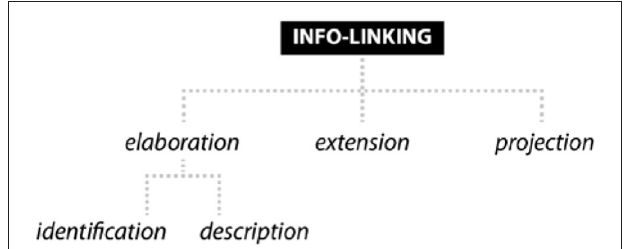
FIGURE 5 | Taxonomic overview of concepts for an analysis of information-linking in print ads.